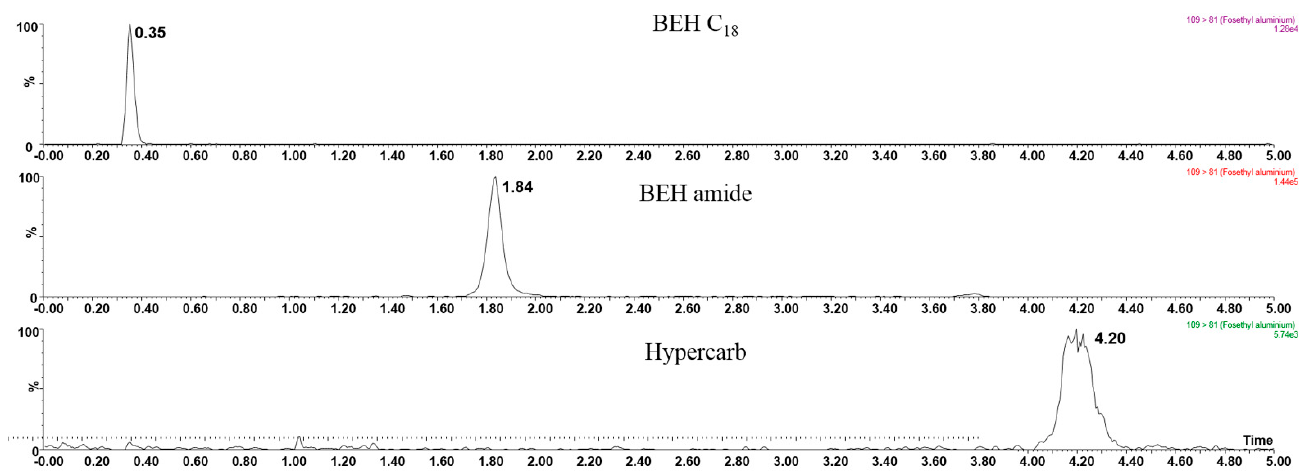
Figure 2. Performance comparison between three types of columns.